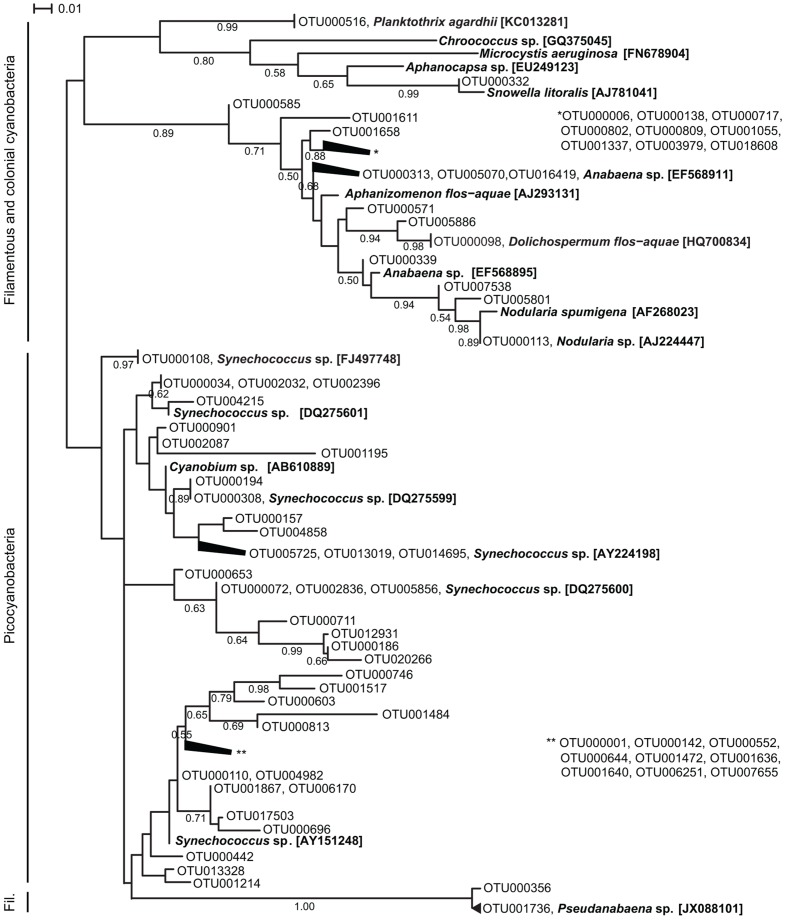
Maximum likelihood tree based on representative sequences of OTUs (98% identity) of partial 16S rRNA gene sequences (cut to 350 bp long). For clarity, the 50 most abundant OTUs for 2010 and 2011, respectively (72 OTUs in total) are shown in the tree and branches of <0.01 distance have been collapsed. Reference sequences were retrieved from NCBI and their accession numbers are shown in brackets. Branch lengths were determined using the Tamura-Nei model, bootstrap values were calculated (1000 replicate trees) and are displayed when greater than 0.50.